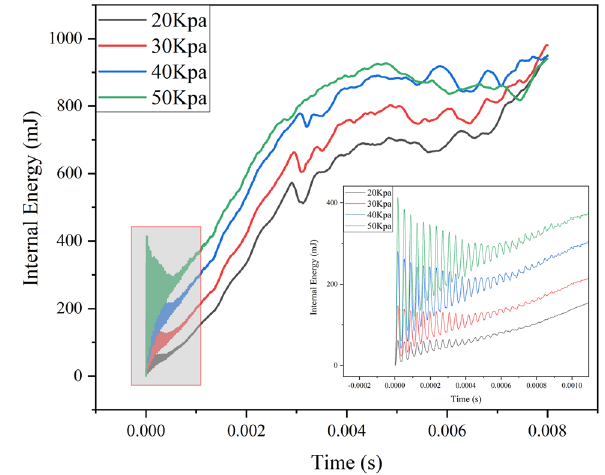
Fig. 10 Cushion pad kinetic energy-time change curve Fig. 11 Cushion pad internal energy-time change